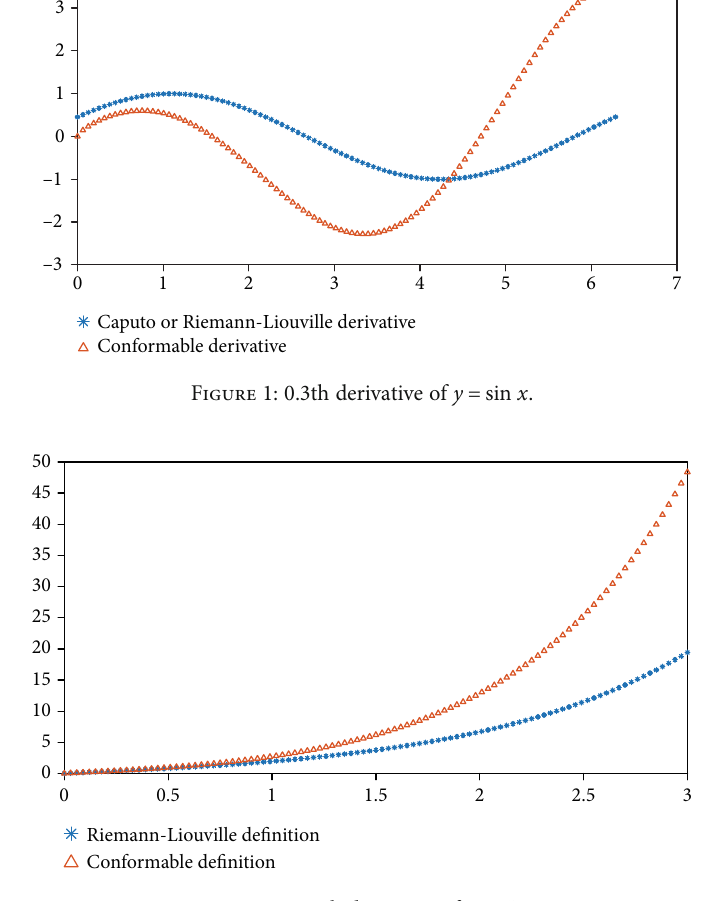
Figure 2: 0.2th derivative of y = e x